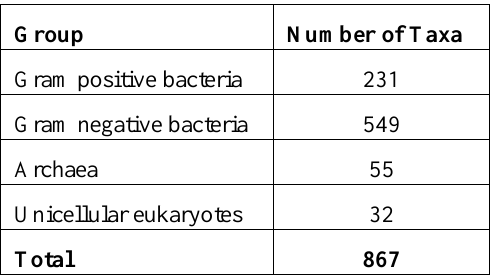
Table 1. Composition of the workflow input